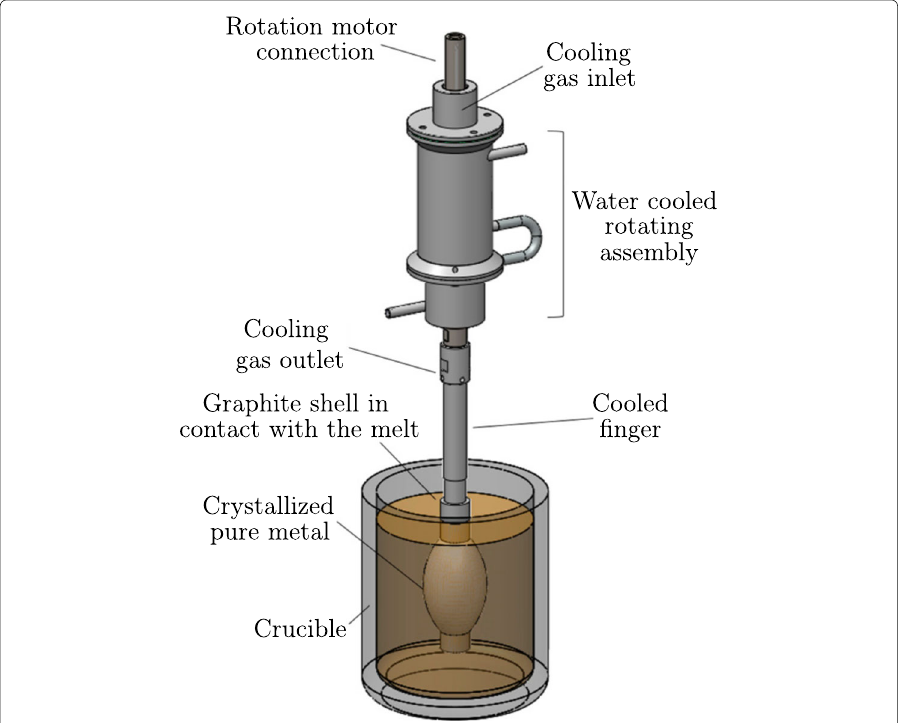
Fig. 1 Schematic drawing of the “cooled finger” device (Friedrich et al. 2017)